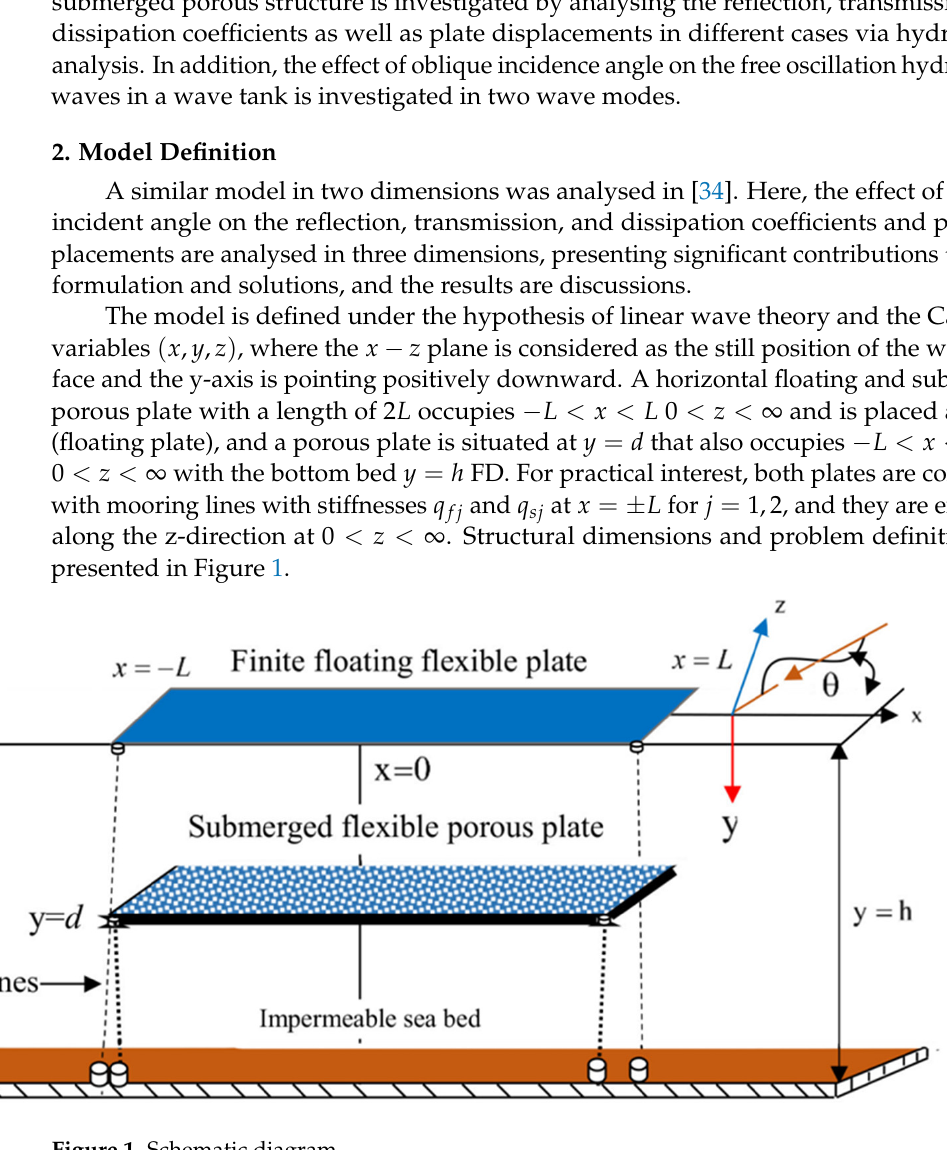
Figure 1. Schematic diagram.